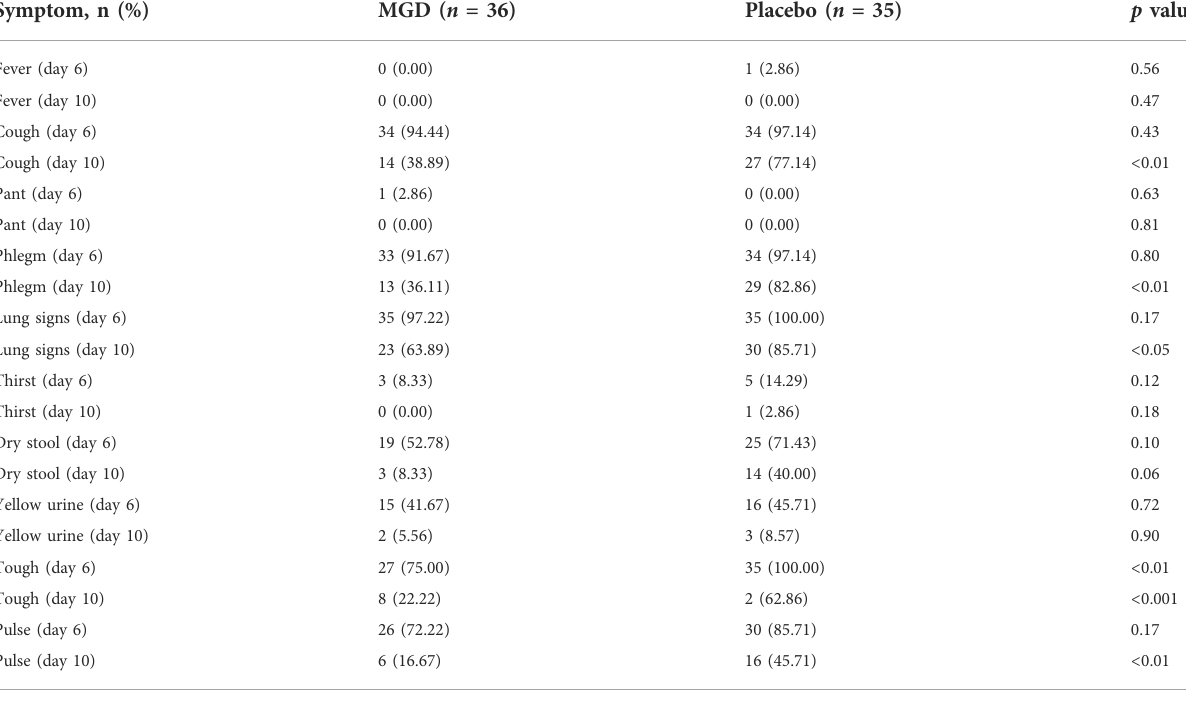
TABLE 3 Change in symptoms after 6 days and 10 days of intervention.